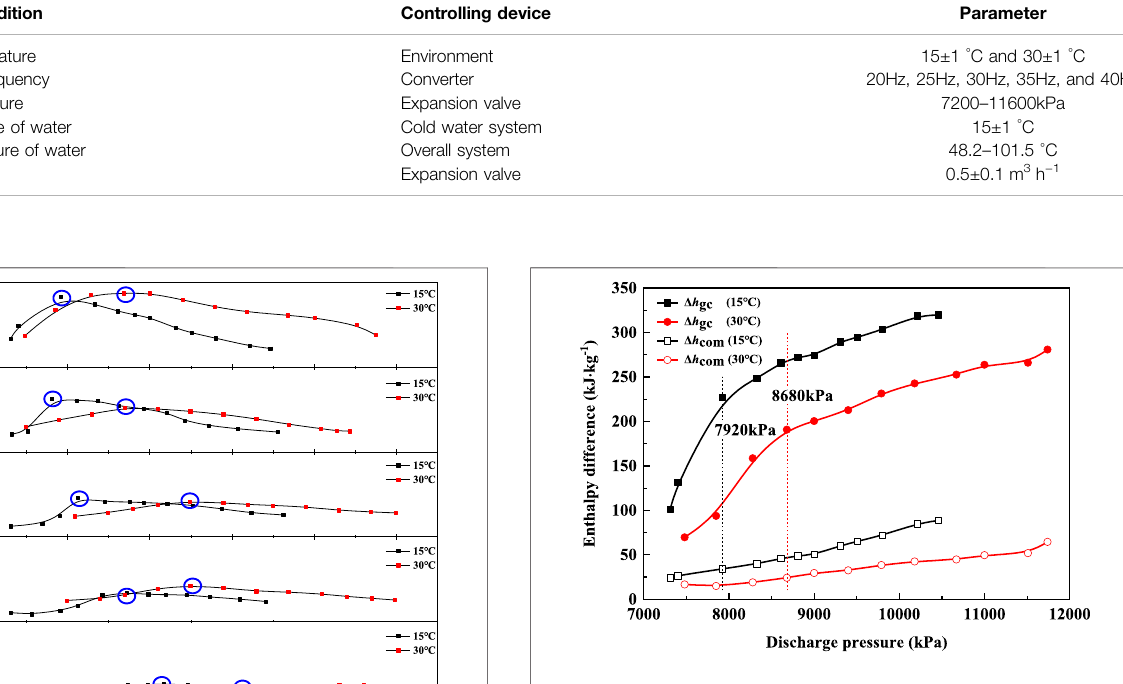
FIGURE 5 | Enthalpy difference of gas cooler and compressor when the compressor frequency is 20 Hz.